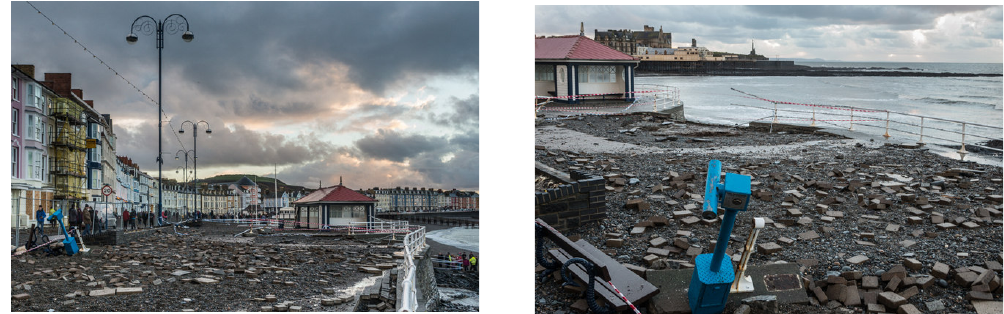
Figure 3. Photos demonstrating the damage along the promenade. The Bandstand lies on cross section North Marine Terrace